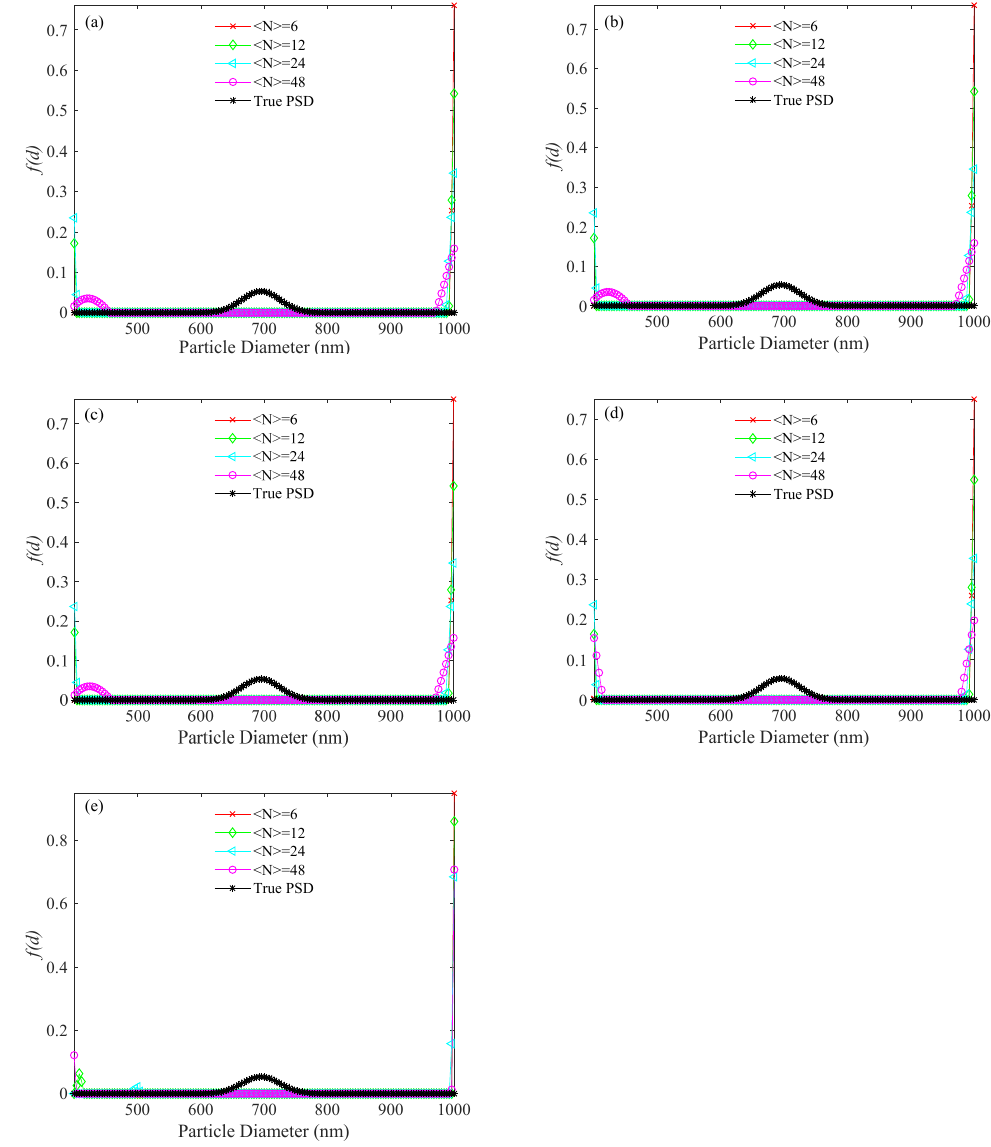
Figure 7. PSD recovered by the usual method for a 696 nm unimodal sample at number concentrations of < N > = 6, 12, 24, 48, and different levels of noise. ( a ) 0, ( b ) 10 − 4 , ( c ) 10 − 3 , ( d ) 10 − 2 , and ( e ) 10 − 1 noise levels.